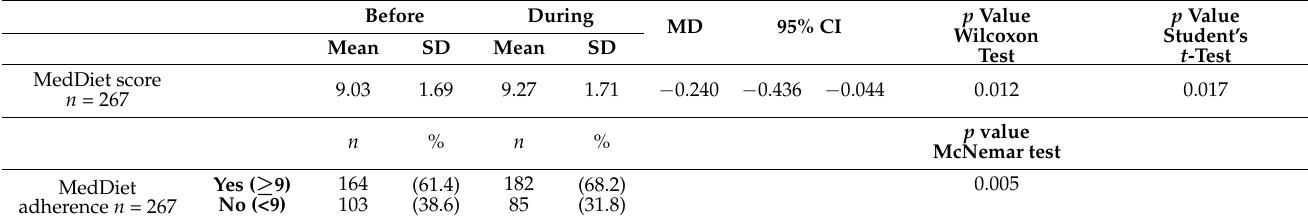
Table 2. Mediterranean diet (MedDiet) score and adherence (yes/no) before and during the COVID-19